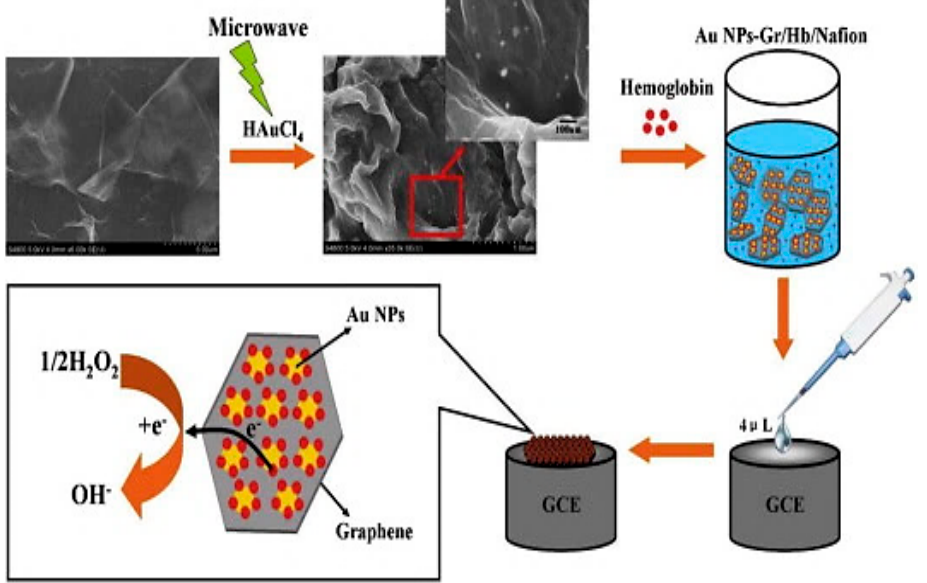
Figure 9. Fabrication steps of AuNPs–Graphene/Hb/Nafion/GC electrode and electrocatalytic activity for H 2 O 2 . Adapted from [87], with permission from ©2014 Elsevier.